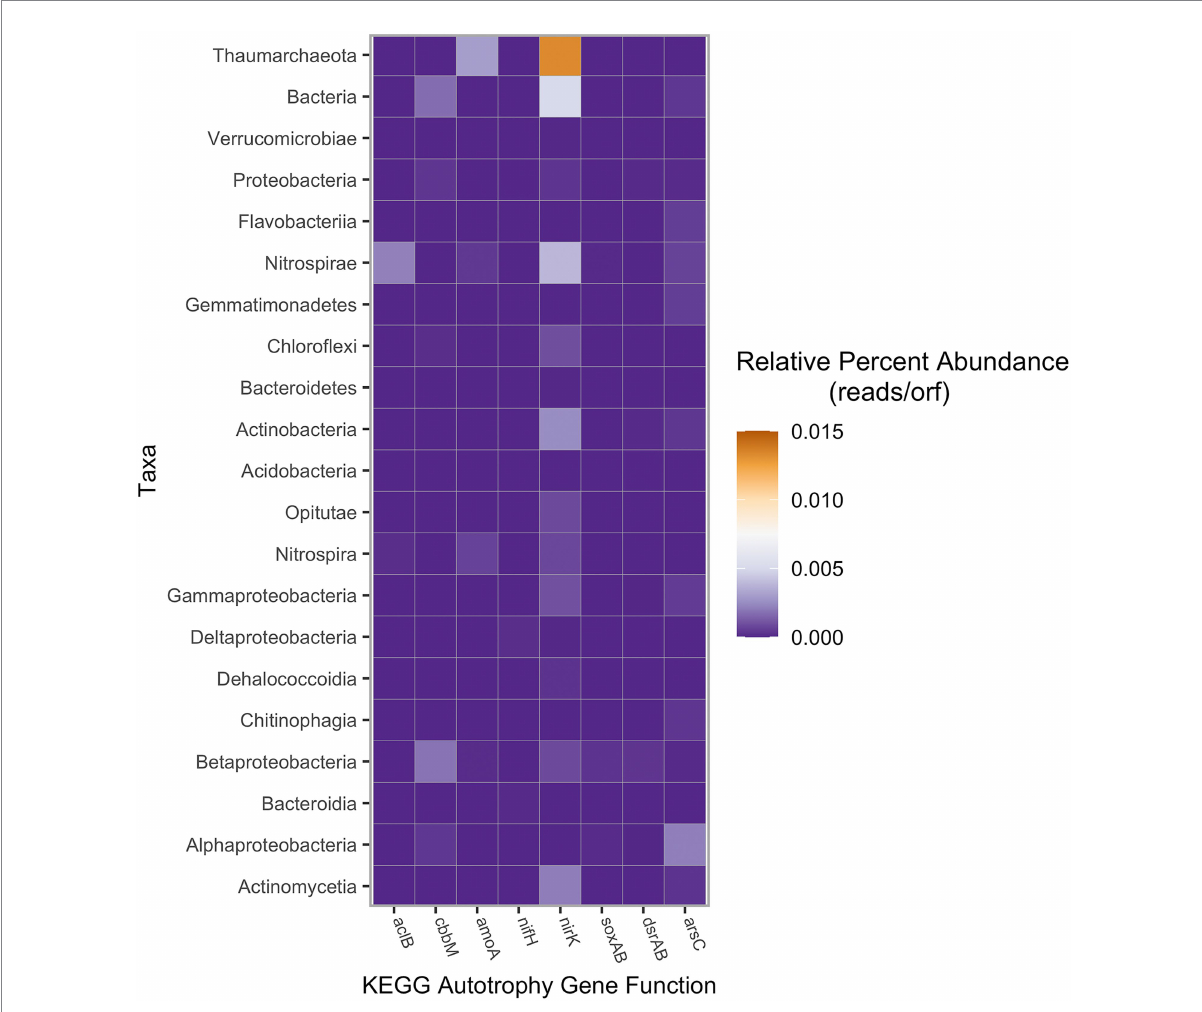
FIGURE 5 Autotrophy gene abundance based on assigned taxa, measured in percent of raw reads per total number of reads in the sample. KEGG gene abundance was calculated using SqueezeMeta with a lowest abundance threshold of 1.25 × 10 − 5 reads per ORF (Tamames and Puente-Sánchez, 2019). Taxa represented by super-taxa (e.g., Thaumarchaeota, Bacteria, etc.) were each the unclassified residual reads not included in the sub-taxa (either phyla or class) listed below,